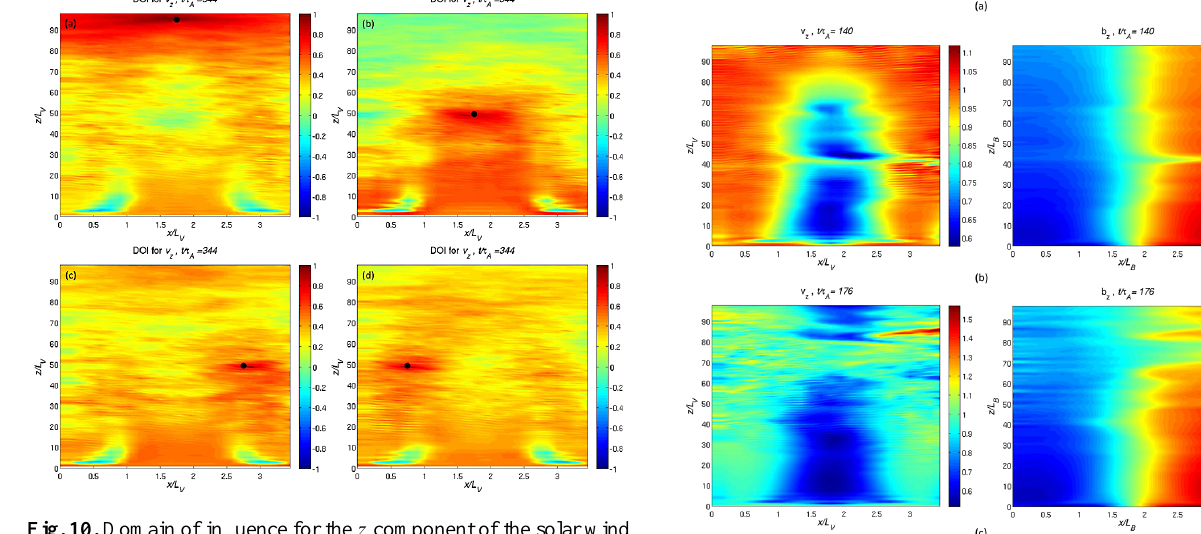
Fig. 10. Domain of influence for the z component of the solar wind velocity v z for the assimilation of a velocity observation taken at different locations at the same time step t/τ A = 334. The black cir- cle indicates the data observation location. (a) refers to location 4 (L1, 1 AU), (b) to location 3, (c) to location 5 and (d) to location 6. The spatial dimensions are normalised to L v = L B , the length scale of variation of the velocity; time is normalised to the Alfvén time τ A .